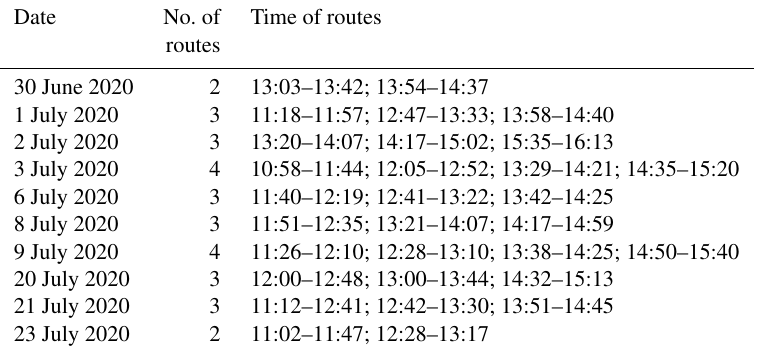
Table A1. Details of the number of times the route was driven each day and the times that the drives took place. Time zone is BST. Date No. of Time of routes